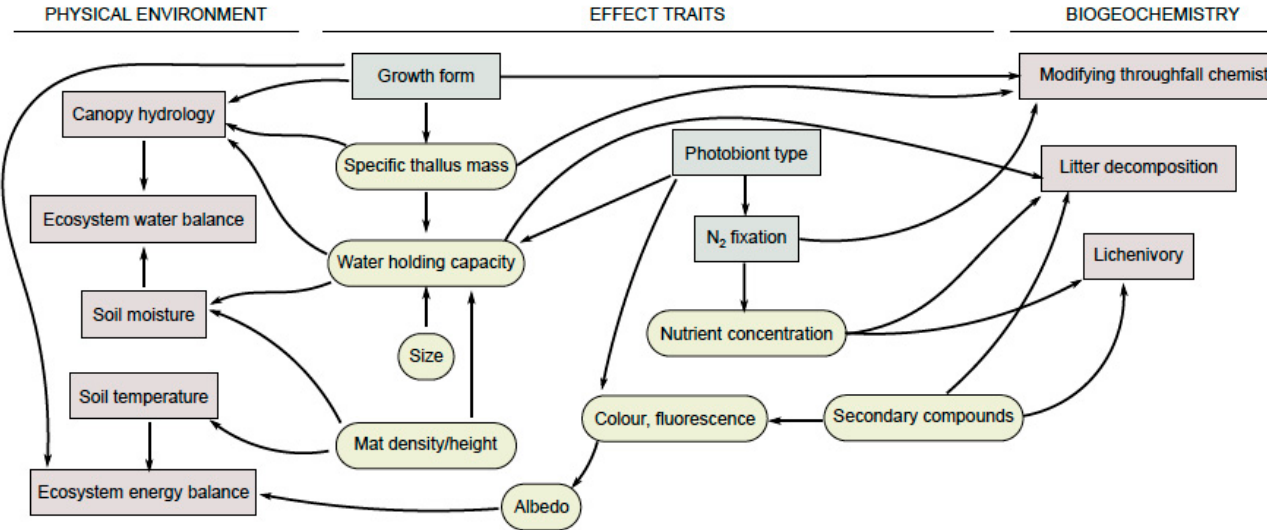
Figure 2. A schematic to suggest how lichen response traits, especially those linked to the key physiological parameter of thallus hydrology (growth form, photobiont type), can also affect the physical environment of energy and water balance as a regulating ecosystem service, while also linking to biogeochemistry as a supporting ecosystem service. As regards the effect traits, boxes represent what are routinely categorical and ellipses continuous measurements.